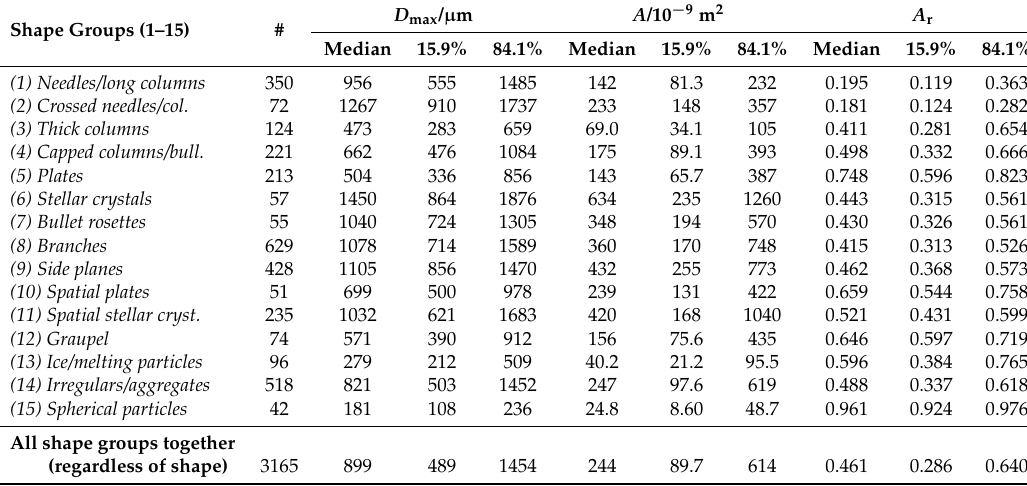
Figure 4. Microphysical properties of snow crystals for each shape group are shown in solid lines. The median and the spread corresponding to ( a ) particle size, D max ; ( b ) cross-sectional area, A ; and ( c ) area ratio, A r , are shown. Values of the median are represented as points. Lower and upper ends of the vertical bars are given by the percentiles 15.9% and 84.1%, respectively, representing the data spread. For comparison, median and the spread corresponding to all data (regardless of shape) are also shown in black dashed lines. Table 8. The total number of particles, #; particle size, D max ; cross-sectional area, A ; and area ratio, A r , for the shape groups. The median and percentiles 15.9% and 84.1% are displayed. For comparison, results for all the data, i.e., all the shape groups together regardless of shape, are also shown. Shape Groups